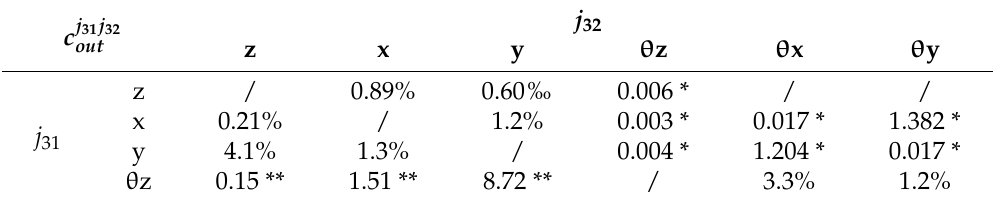
Table 6. Output coupling ratio of the 6-RRRR CPM using the FEM.